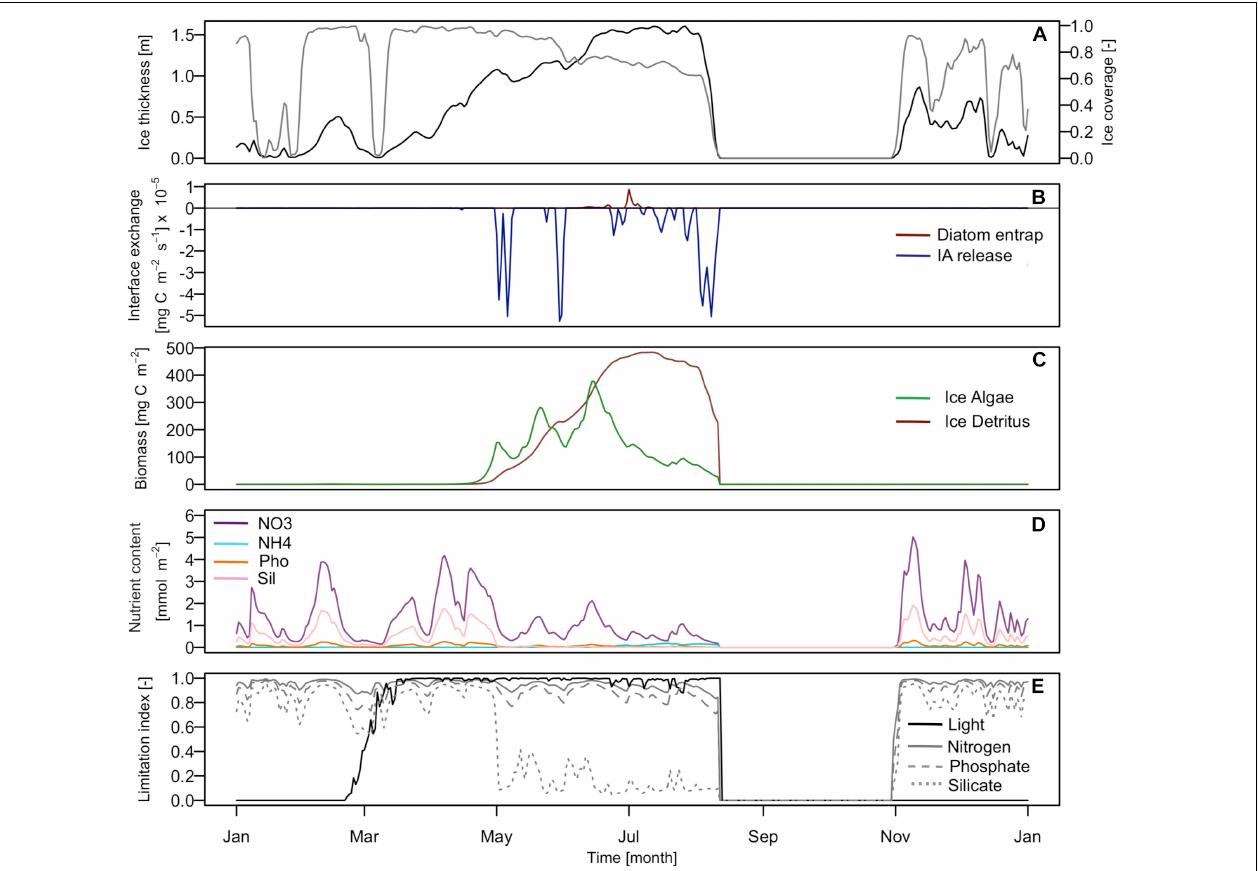
FIGURE 3 | Seasonal variation in the environmental forcing (A) of ice thickness (black) and ice coverage (gray) in 1997; (B) diatoms/ice algae flux at the ice-ocean interface. (Red line represents the quantity of diatoms entrap into the sympagic system and the blue line represents the quantity of ice algae released into the pelagic system.); (C) the ice algae (green) and detritus in ice (red) biomass; (D) integrated nutrient content in the sea ice: nitrate (NO 3 : purple), ammonium (NH 4 : light green), phosphate (Pho: orange), and silicate (Sil: pink); (E) light (black) and nutrients (gray) ice algae growth limitation index. Nitrogen (solid), phosphate (dashed), and silicate (dotted) are